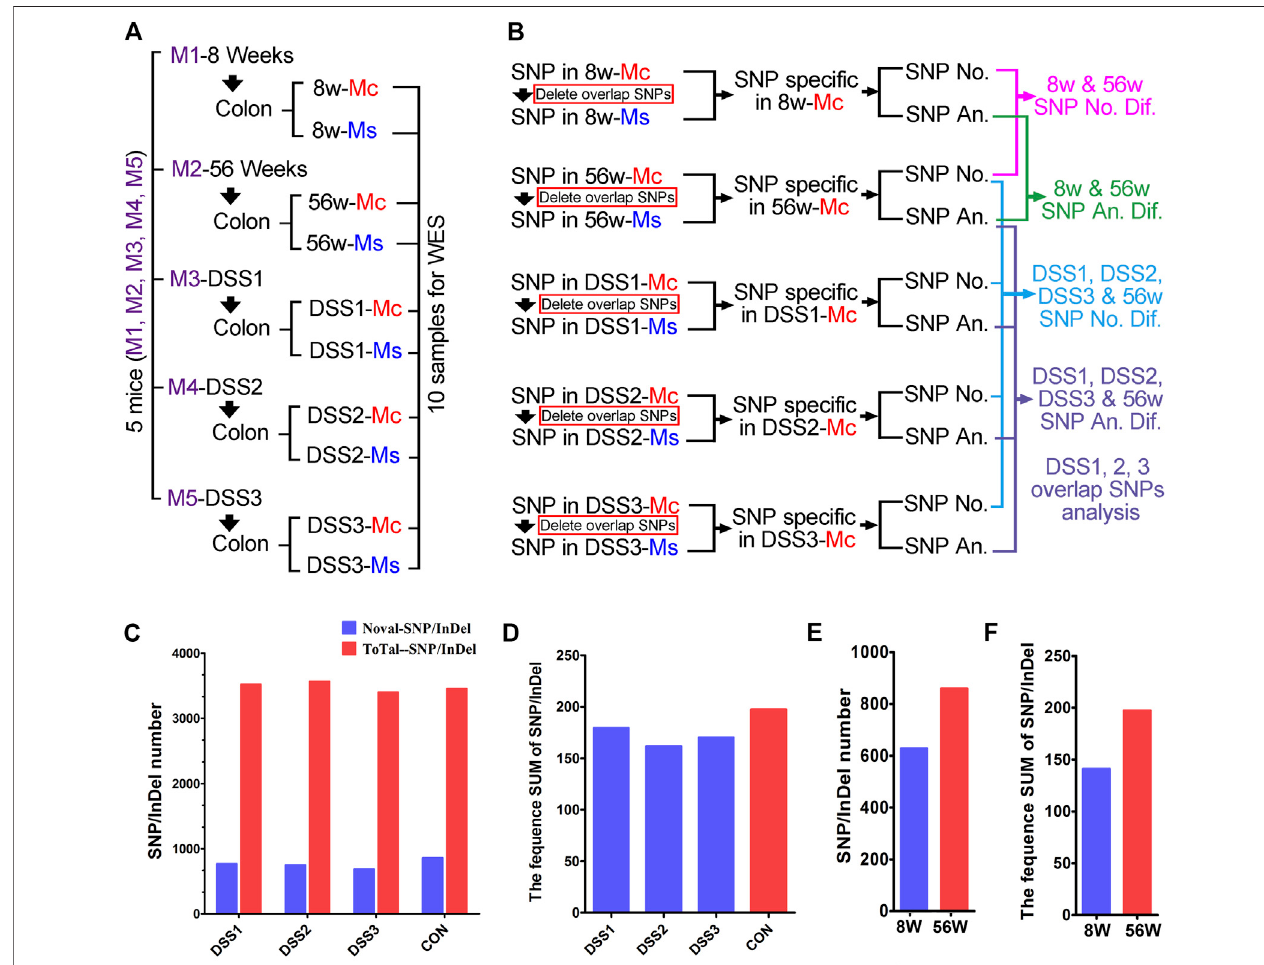
FIGURE2| Comparativeandquantitativeassaysofsingle-nucleotidepolymorphism/insertionordeletion(SNP/InDel)inthecolitistissue. (A) Tensamplesfrom fi ve mice were used for whole-exome sequencing (WES), mucosa (Mc) and muscularis (Ms) isolation and sequenced individually. (B) Comparative assay strategy for the WESresult;SNP/InDelfromtheMcandMsofsamemicewascomparedtowipeoffthegermlinemutation.Bothstatisticalandannotativeassayswereperformedonthe SNP/InDel speci fi c in Mc from different mice. (C) The total SNP/InDel number in the mucosa of three dextran sulfate sodium (DSS)-induced colitis mice is 3,521/ 3,570/3,400; for the no colitis mouse, the SNP/InDel number is 3,456. The novel somatic SNP/InDel number in the three DSS-induced colitis mice is 769/753/687; in age-matched(56W) no-colitiscontrolmouse, theSNP/InDelnumber is860. (D) SNP/InDel frequency SUMis179/162/170inthreeDSS-inducedcolitismice andis195 in the control mice. (E) The SNP/InDel number is obviously elevated in the older mouse (56 weeks, SNP/InDel: 860) compared with the young mouse (8 weeks, SNP/ InDel: 629). (F) The SNP/InDel frequency SUM in 56W mouse was obviously increased compared with that in the 8W mouse.